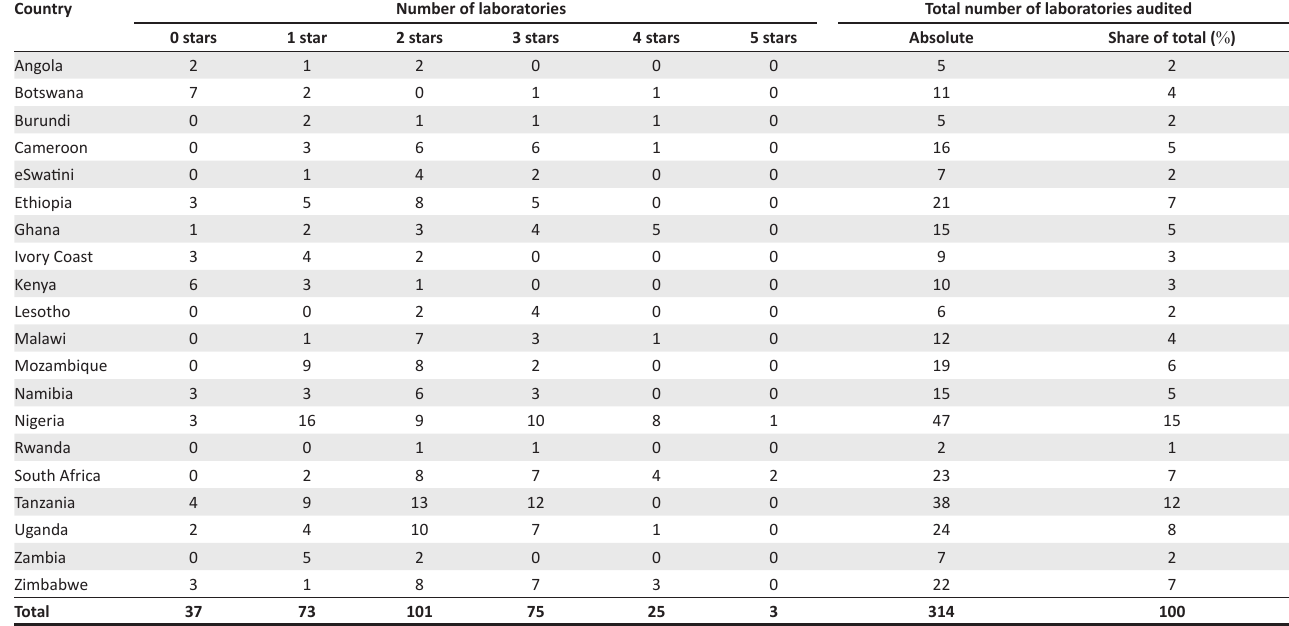
TABLE 3: Number of laboratories per star level per country on 24 April 2019. 18 Country